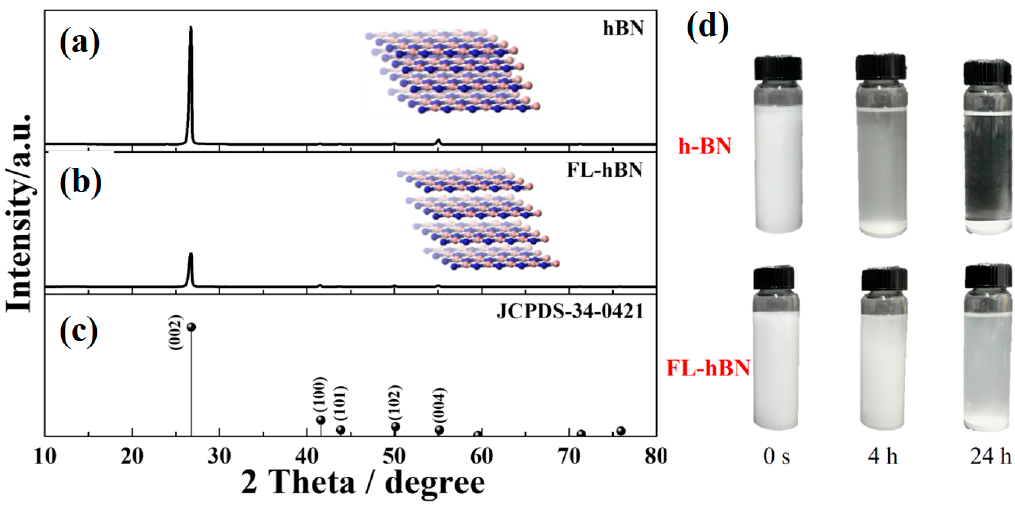
Figure 2. XRD patterns of: ( a ) h-BN; ( b ) FL-hBN; ( c ) standard data JCPDS-34-0421. Photo images ( d ) of h-BN and FL-hBN solutions with different settling times.